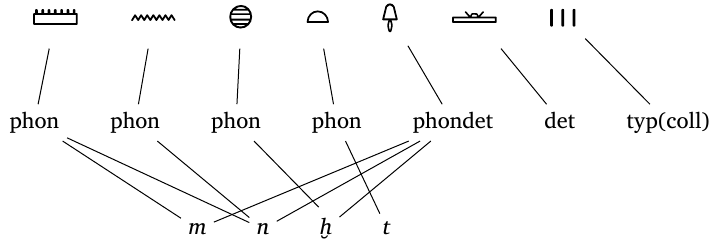
Figure 1: Use of a phonetic